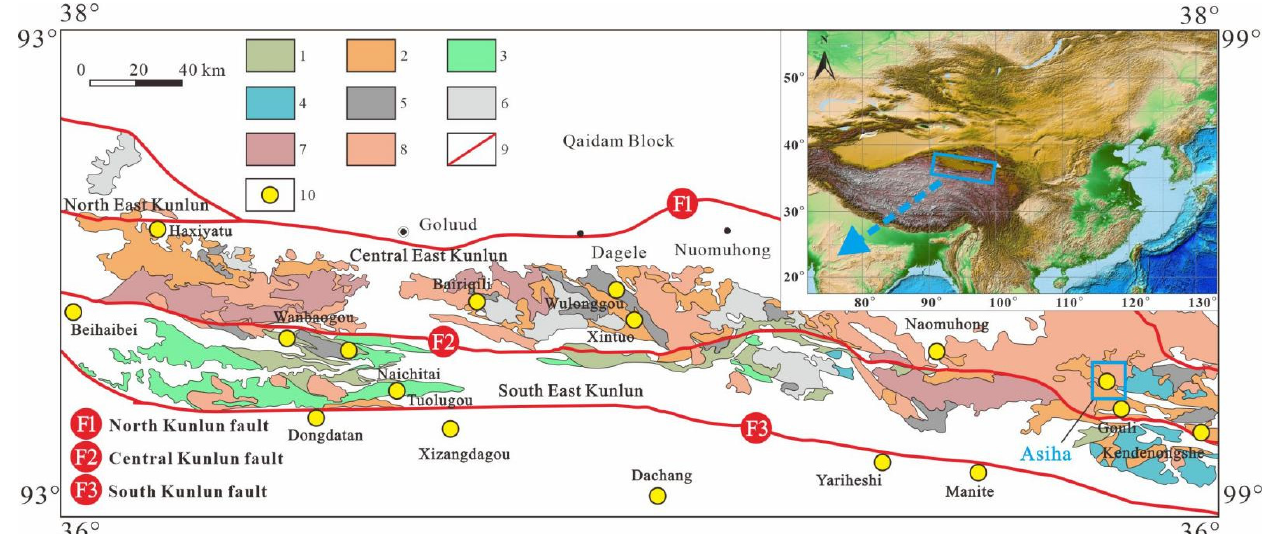
Figure 1. Simplified tectonic units of the East Kunlun Orogenic Belt. 1. Proterozoic Wanbaogou Group; 2. Proterozoic Jinshuikou Group; 3. Proterozoic Nachitai Group; 4. Ordovician intermediate-acid intrusion; 5. Devonian intermediate-acid intrusion; 6. Silurian intermediate-acid intrusion; 7. Permian intermediate-acid intrusion; 8. Triassic intermediate-acid intrusion; 9. Fault; 10. Gold de- posit.